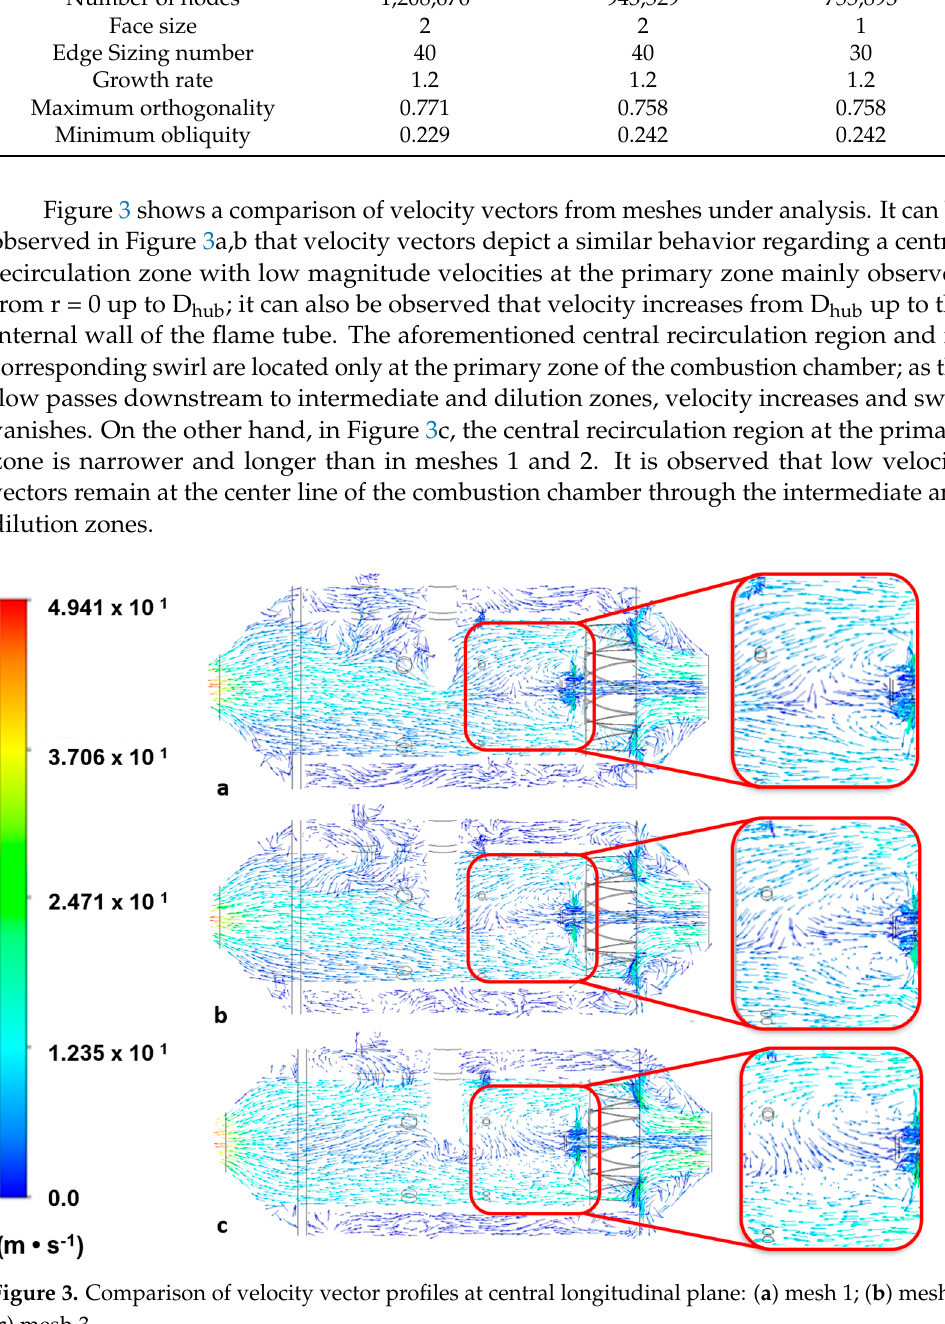
( c ) mesh Figure 3. Comparison of velocity vector profiles at central longitudinal plane: ( a ) mesh 1; ( b ) mesh 2; ( c ) mesh 3.